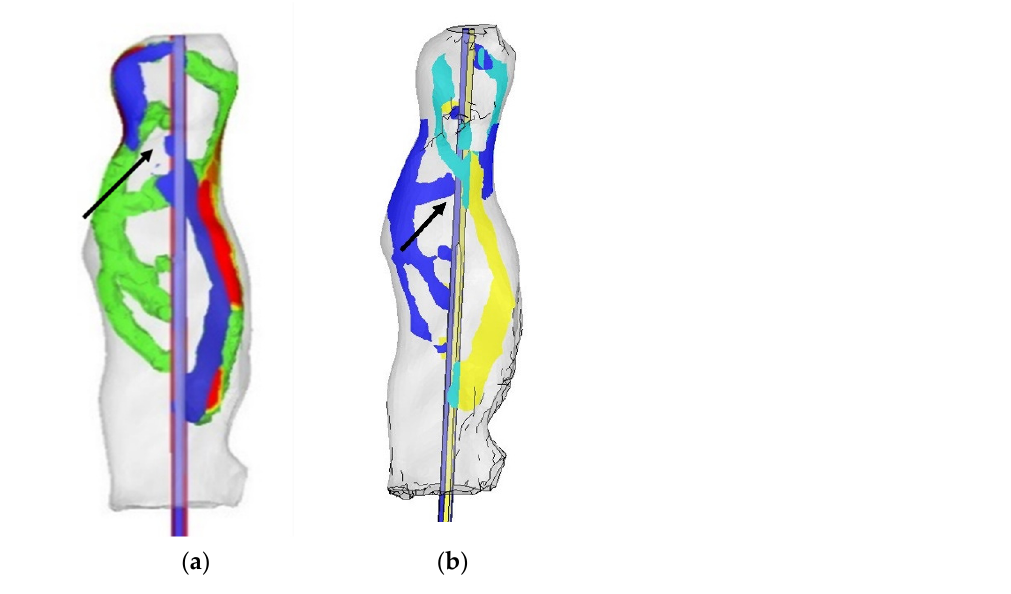
Figure 9. ( a ) Density distribution due to CBWA_Sa (sectional View); ( b ) Integrated sectional view.